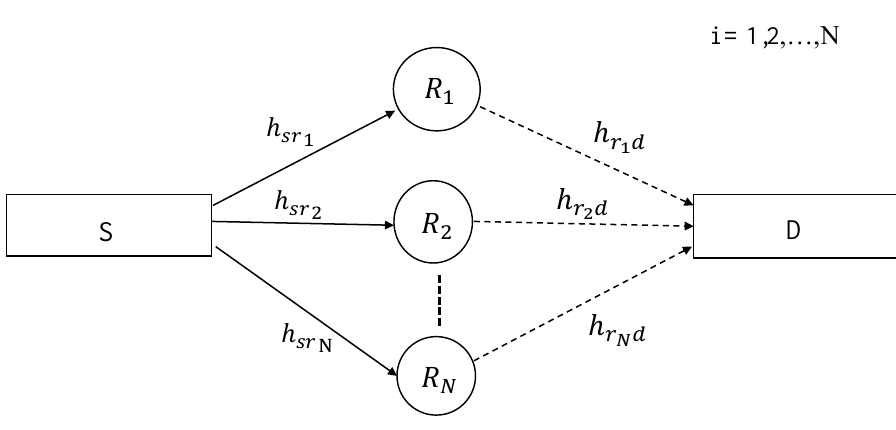
Figure 1. Two-hop multiple-relay network.